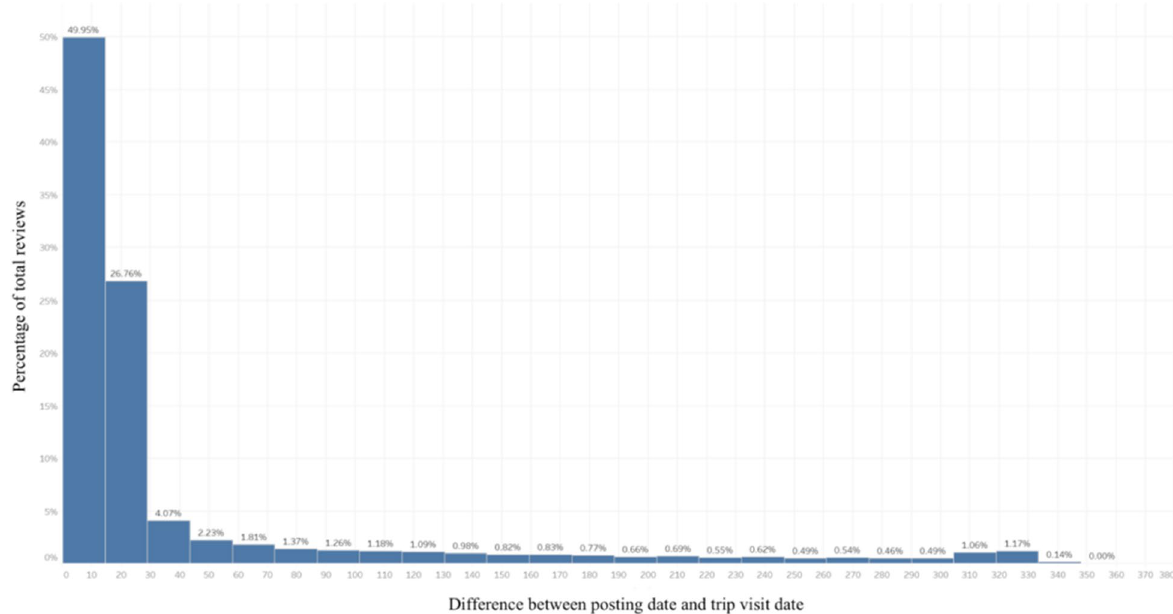
Fig. 6 Distribution of differences between posting date and trip visit